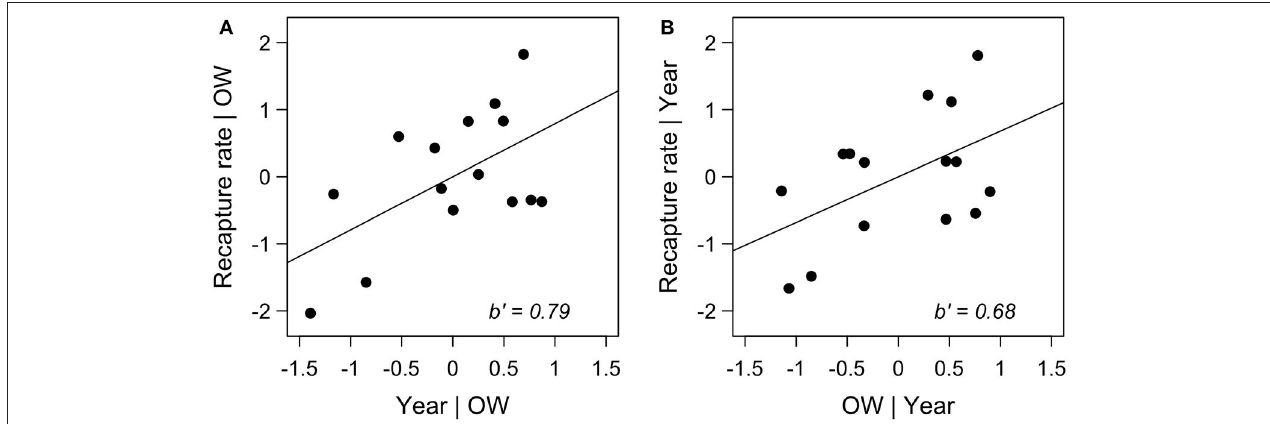
FIGURE 1 | Partial regression plots for a model where total recapture rate is predicted by year and over-wintering colony size (OW). The left panel (A) shows the relationship between recapture rate and year while controlling for over-wintering colony size ( F 1, 12 = 5.60, p < 0.05; standardized slope ± SE = 0.79 ± 0.33), while the right panel (B) is the relationship between recapture rate and OW while controlling for year ( F 1, 12 = 4.16, p = 0.06; standardized slope ± SE = 0.68 ± 0.33). Data were standardized for ease of comparison. Failure to detect an effect of over-wintering colony size at α = 0.05 is most likely due to overall low power of the model (power = 0.56). A positive coefficient for the effect of year was also present in models restricted to Midwest or Northeast